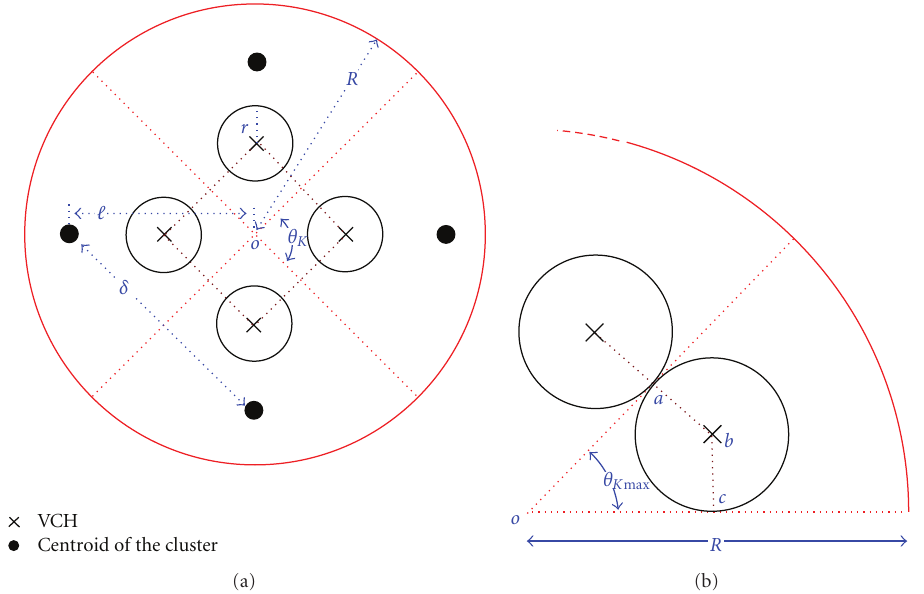
Figure 4: The maximum number of clusters. (a) Transmission range of VCHs is not overlapped. (b) Probability of finding real cluster head is proportional to the ratio of the area oabc to the sensing field.